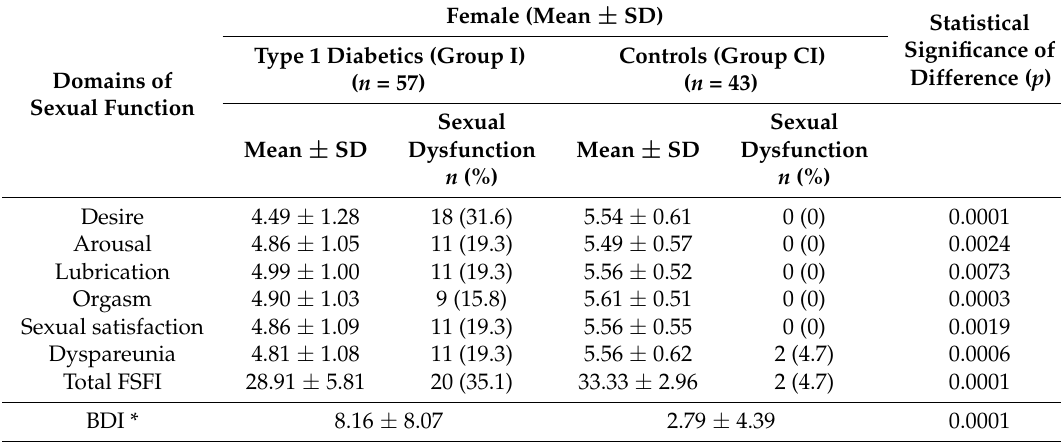
Table 2. Sexual function and Beck Depression Inventory (BDI) characteristics in diabetic women and